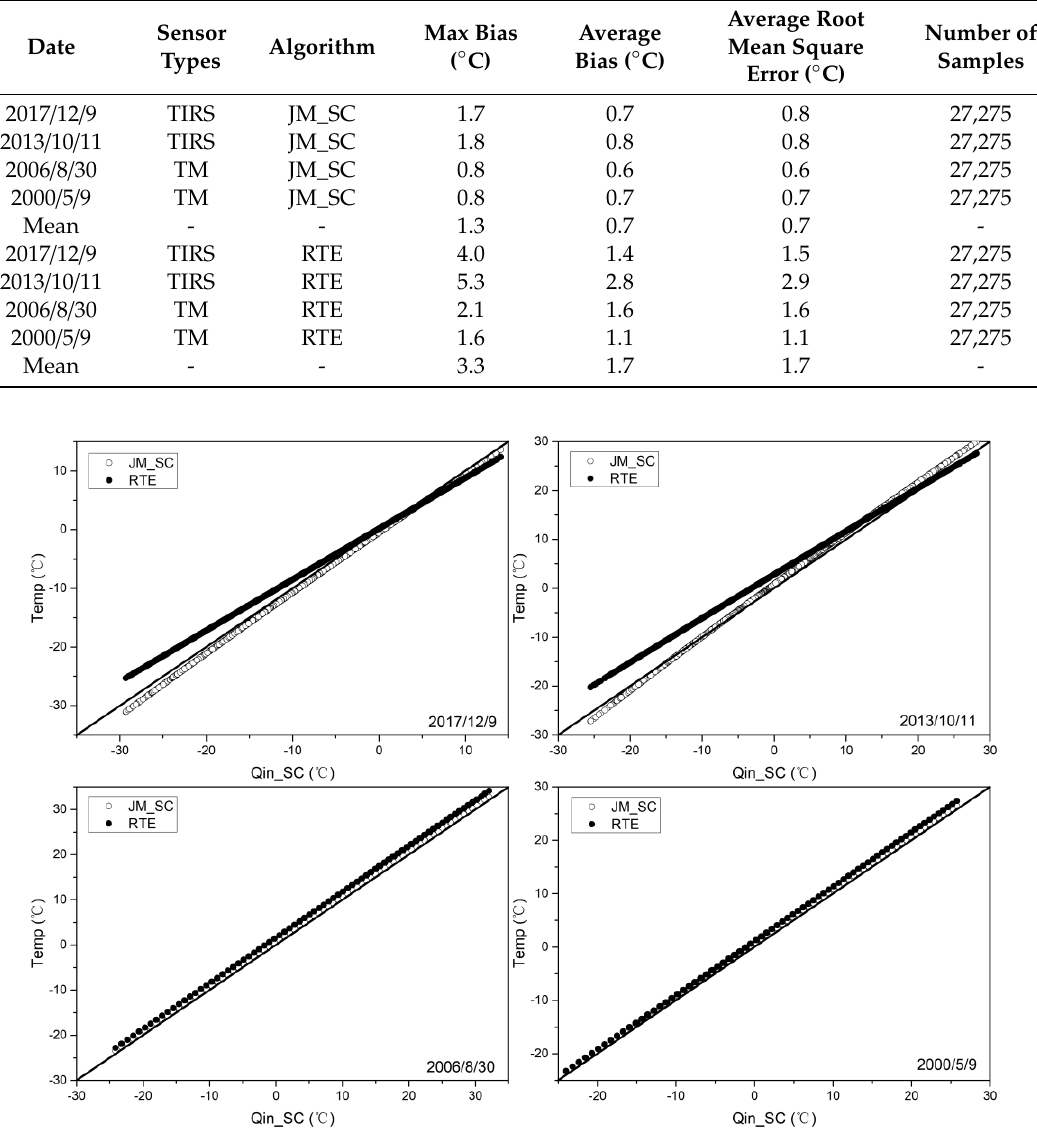
Table 6. The results of the comparison between the remote-sensing-retrieved temperatures in this paper with two other single-channel algorithms. Jim é nez-Muñoz et al.’s single-channel algorithm (JM_SC) is the method developed by Jim é nez-Muñoz and Sobrino in 2003; RTE, radiative transfer equation.